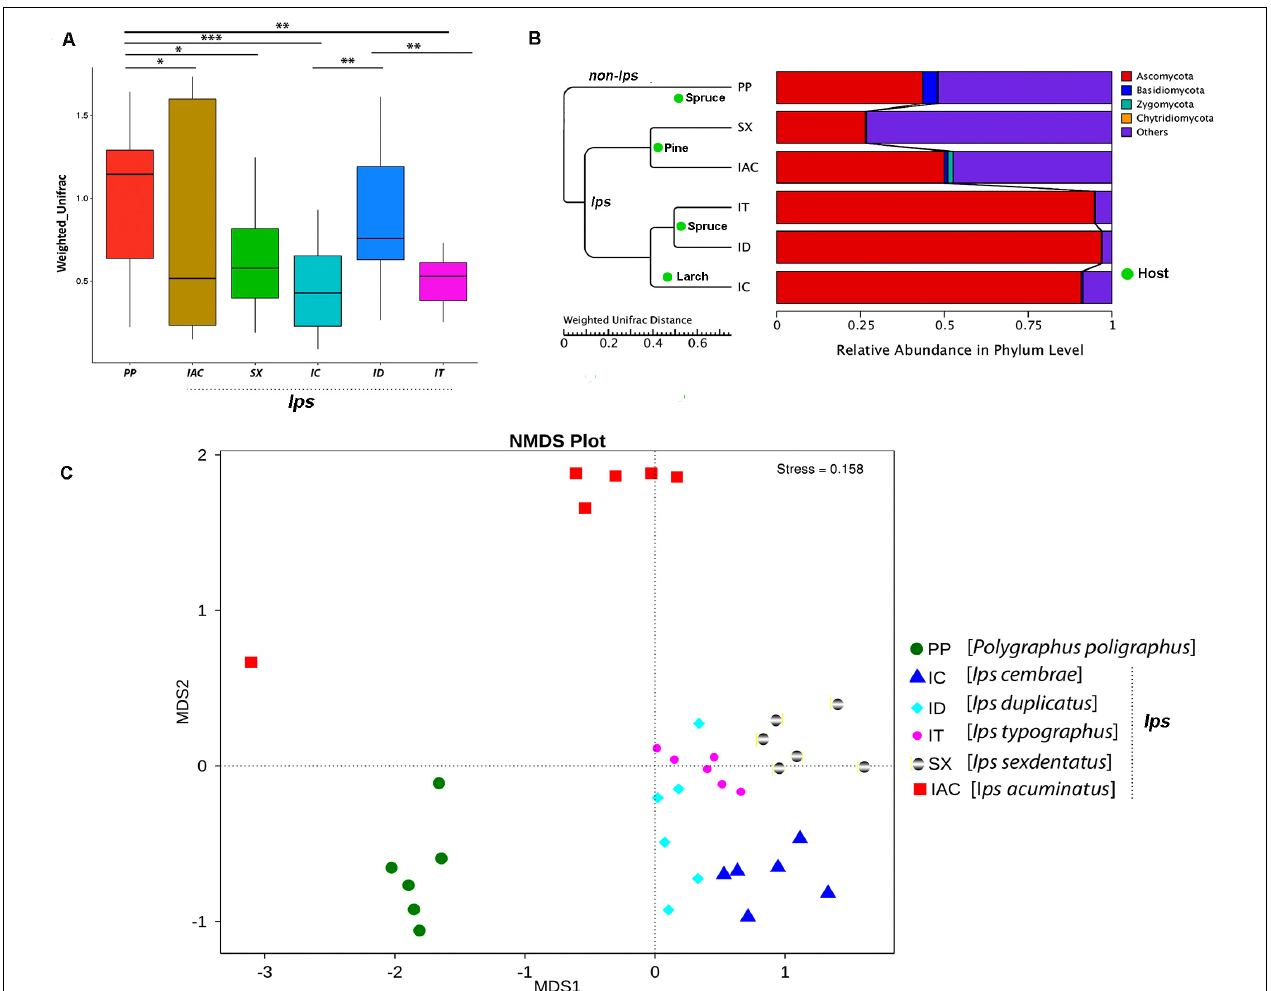
FIGURE 5 | Beta diversity analysis. (A) The boxplot representing the diversity between the bark beetles based on the Weighted Unifrac distances showing significant differences between the PP and other bark beetles. The statistical analysis for significance is performed by Wilcoxon signed-rank test where the significance level at p < 0.05 is denoted by “ ∗ ,” “ ∗∗ ” designates p < 0.01 and “ ∗∗∗ ” signifies p < 0.001. (B) The WPGMA (Weighted pair group method with arithmetic mean) tree cluster based on Weighted Unifrac distance illustrates the similarity in gut fungal communities among the Ips species of bark beetles (IT, ID, IC, SX, and IAC) compare to non- Ips bark beetle PP. Additionally, bark beetles feeding on similar conifer host are grouped. The WPGMA tree displayed with the relative abundance of the gut mycobiome at phylum level. (C) Non-metric multidimensional scaling analysis (NMDS) representing the variation in the gut fungal communities between the six bark beetles. The data points in the same color denote the same bark beetle species. The different bark beetles are denoted by different symbols. The bark beetles collected from Rouchovany (IT, ID, IC, SX) are clustered together and are significantly different from the bark beetles sampled from other locations, Kostelec (PP) and Libavá